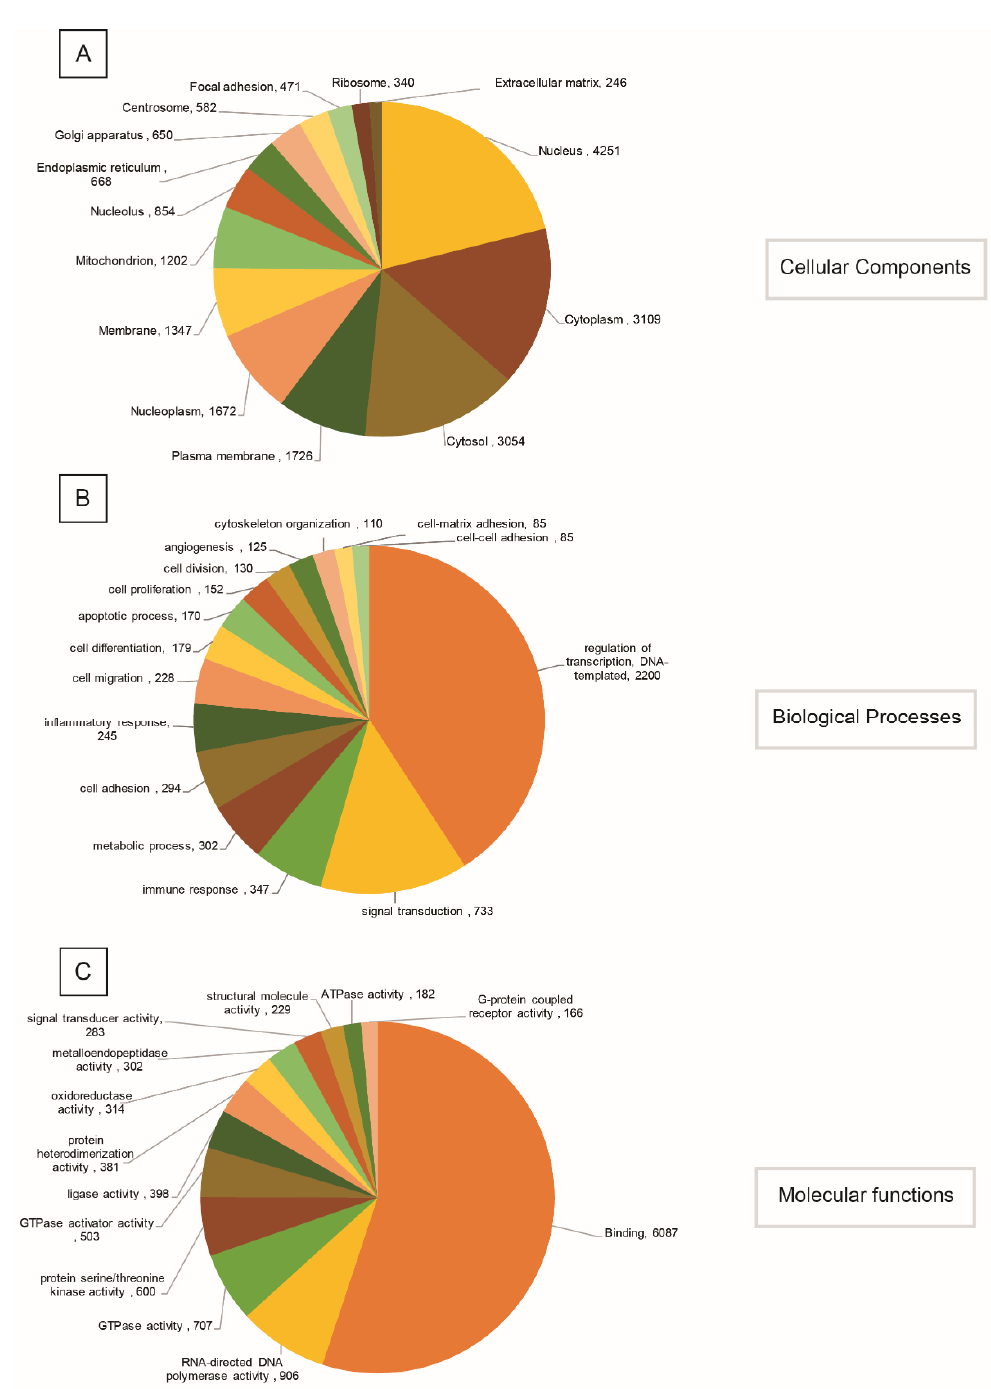
Figure 3. Gene Ontology classification of Unigenes derived from sequencing in H. flaviviridis during tail regeneration belonging to categories for cellular components ( A ), biological processes ( B ), and molecular functions ( C ).